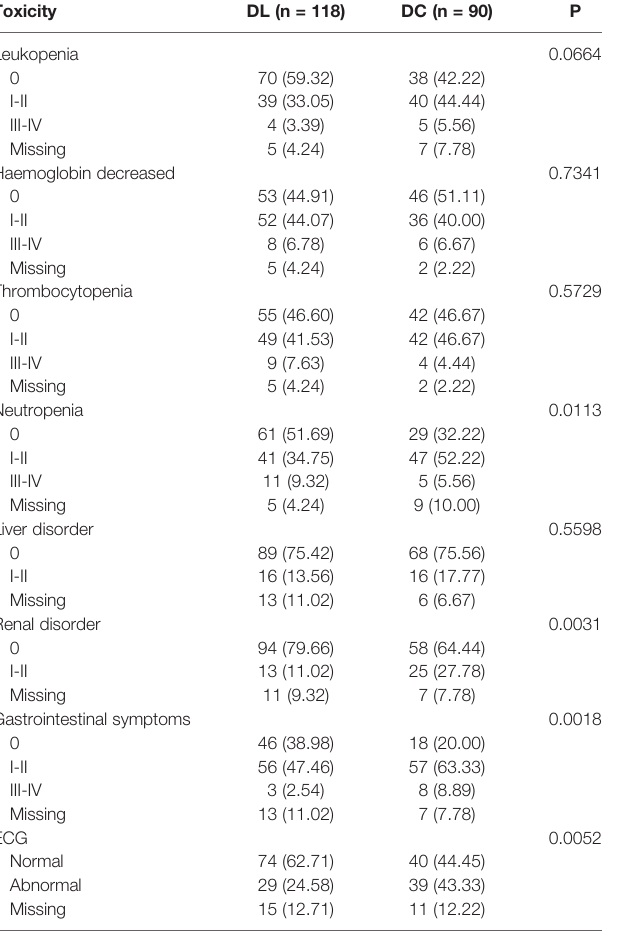
TABLE 4 | Subgroup analysis of side effects of 1 – 2 cycles of adjuvant therapy (DL versus DC). Toxicity DL (n = 118) DC (n = 90) P Leukopenia